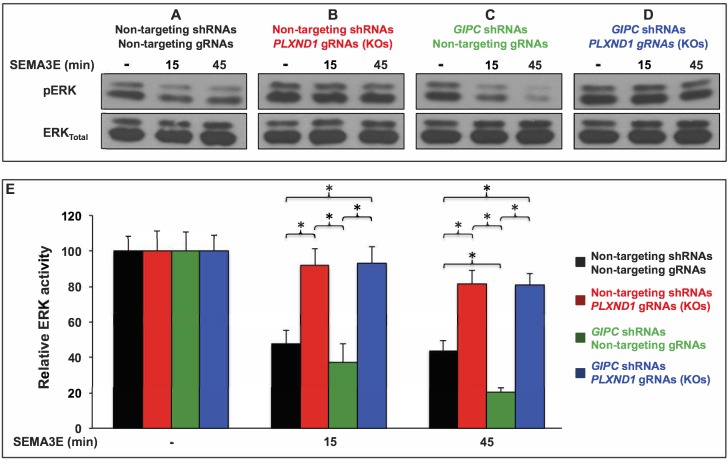
GIPC depletion potentiates SEMA3E-induced, PLXND1-dependent ERK inactivation in HUVEC/TERT2 cells.(A–D) Representative Western blot of active ERK1/2 (pERK) and total ERK1/2 (ERKTotal) from total cell lysates of HUVEC/TERT2 cells under the four conditions (shRNA and gRNA combinations) and the three ligand treatments indicated. Conditions. Control (A; bold black font), PLXND1 loss (B; bold red font), GIPC loss (C; bold green font), and GIPC-PLXND1 double loss (D; bold blue font). Treatments. Vehicle (-) and 2 nM SEMA3E for the indicated times. Cells stably carried a vector coexpressing the Cas9 nuclease and the indicated gRNAs. The alleles of the PLXND1 gRNAs (KOs) are stable and defined (see Supplementary file 1 and Supplementary file 8). (E) Bar graph. Means of percentual relative ERK activity (pERK/ERKTotal) under the described conditions (color coded as above) and treatments. Error bars, ± SEM. Relative ERK activity. Statistically significant differences between pairwise combinations of conditions and treatments are indicated (brackets and asterisks). Quantifications. n = 4 independent experiments per PLXND1 gRNA KO (for a pooled total of 8 experiments); n = 4 independent experiments per non-targeting gRNA (for a pooled total of 8 experiments). One-way ANOVA tests were conducted to determine whether relative ERK activity was significantly different between cells in the control, PLXND1 loss, GIPC loss, and GIPC-PLXND1 double loss conditions across each treatment. There were no outliers in the data, as assessed by inspection of a boxplot. Relative ERK activity data were normally distributed, for each treatment, as determined by Shapiro-Wilk’s test (p>0.05) except for the SEMA3E 15 min treatment; p=0.031. There was homogeneity of variances, as assessed by Levene's test (p>0.05) for equality of variances in all conditions. One-way ANOVA tests summary. Relative ERK activity was not statistically significantly different between conditions under vehicle treatment (F(3, 28)=0.004, p=1). Relative ERK activity was statistically significantly different between conditions under SEMA3E 15 min treatment (F(3, 28)=10.291, p<0.0005), effect size was ω2 = 0.46. Relative ERK activity was statistically significantly different between conditions under SEMA3E 45 min treatment (F(3, 28)=28.738, p<0.0005), effect size was ω2 = 0.72. Summary of the four statistically significant differences revealed by Tukey post hoc analysis (between conditions under SEMA3E 15 min treatment). Control versus PLXND1 loss was statistically significantly different (p<0.05): (95% CI (17.2450 to 67.2680); p=0.001). Control versus GIPC- PLXND1 double loss was statistically significantly different (p<0.05): (95% CI (−80.9622 to −12.0628); p=0.005). GIPC loss versus PLXND1 loss was statistically significantly different (p<0.05): (95% CI (17.1753 to 86.0747); p=0.002). GIPC loss versus GIPC-PLXND1 double loss was statistically significantly different (p<0.05): (95% CI (−90.0872 to −21.1878); p=0.001). Summary of the five statistically significant differences revealed by Tukey post hoc analysis (between conditions under SEMA3E 45 min treatment). Control versus PLXND1 loss was statistically significantly different (p<0.05): (95% CI (−59.2432 to −16.5068); p<0.0005). Control versus GIPC-PLXND1 double loss was statistically significantly different (p<0.05): (95% CI (−57.3307 to −14.5943); p<0.0005). GIPC loss versus PLXND1 loss was statistically significantly different (p<0.05): (95% CI 39.9193 to 82.6557); p<0.0005). GIPC loss versus GIPC-PLXND1 loss was statistically significantly different (p<0.05): (95% CI-80.7432 to −38.0068); p<0.0005). Control versus GIPC loss was statistically significantly different (p<0.05): (95% CI (2.0443 to 44.7807); p=0.028). For additional data, graphs, and statistical comparisons related to this figure, see Supplementary file 7.